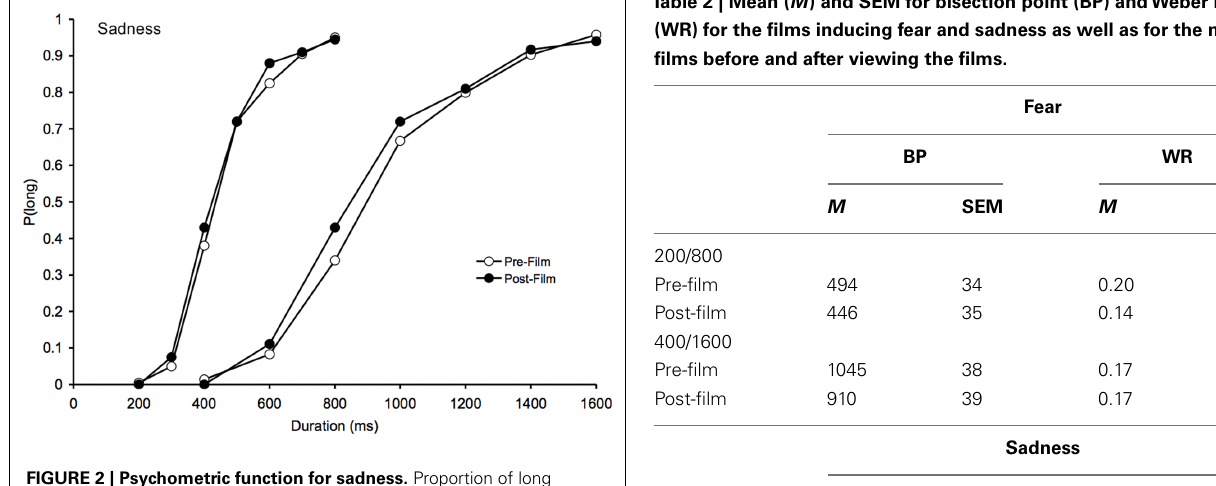
FIGURE 2 | Psychometric function for sadness. Proportion of long responses plotted against probe durations (ms) for the bisection task before and after viewing the sad films in the 200/400 and the 800/1600-ms duration range.